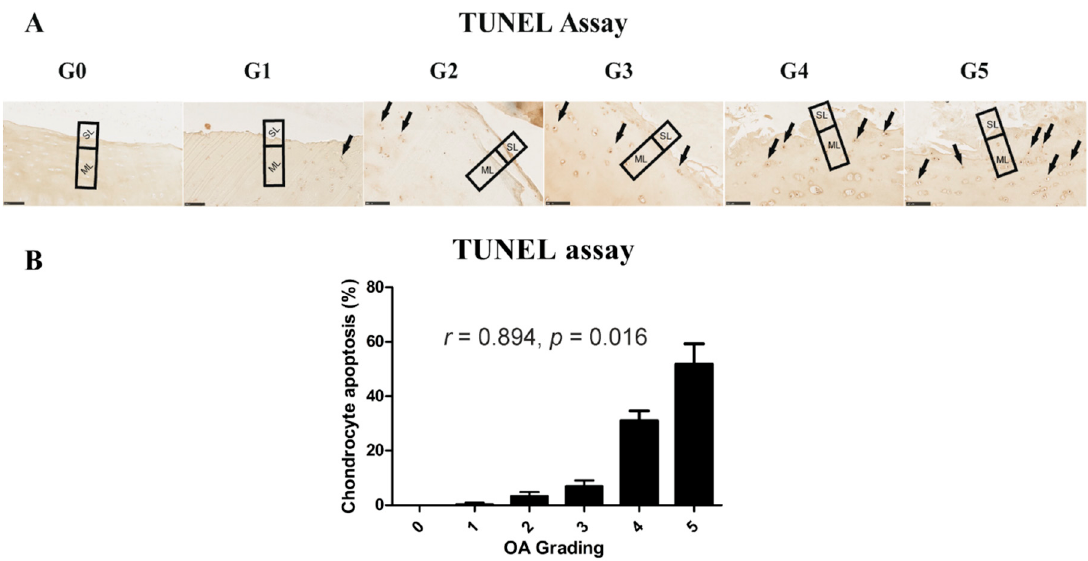
Figure 3. Correlation between histopathological grade and chondrocyte apoptosis. ( A ) The TUNEL assay was performed to identify chondrocyte apoptosis at different stages of OA (scale bar: 100 µm). Arrows indicate apoptotic cells; ( B ) Apoptotic cells were counted in the superficial layer (SL) and middle layer (ML) in cartilage sections for quantification. Apoptosis is quantified as the percentage apoptotic cells with respect to the total cells counted.